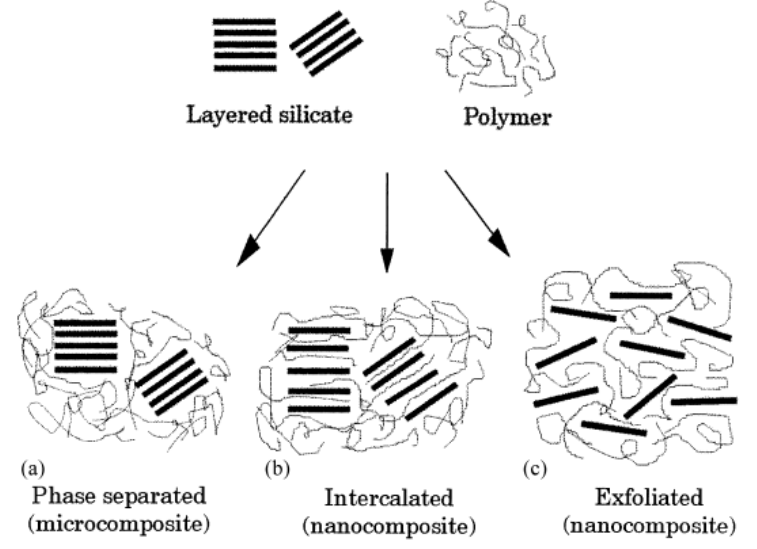
Figure 7. Schematic representation of the different types of composites generated based on the interactions of the layered silicate with polymer matrices. (a) Phase separated microcomposite, (b) intercalated nanocomposite and (c) exfoliated nanocomposite